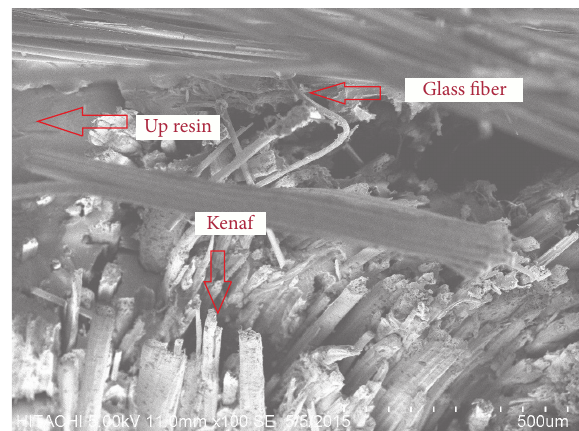
Figure 4: Microimage of tensile failure surface of S1 hybrid composite, showing kenaf, glass fibers, and unsaturated polyester (UP) resin.